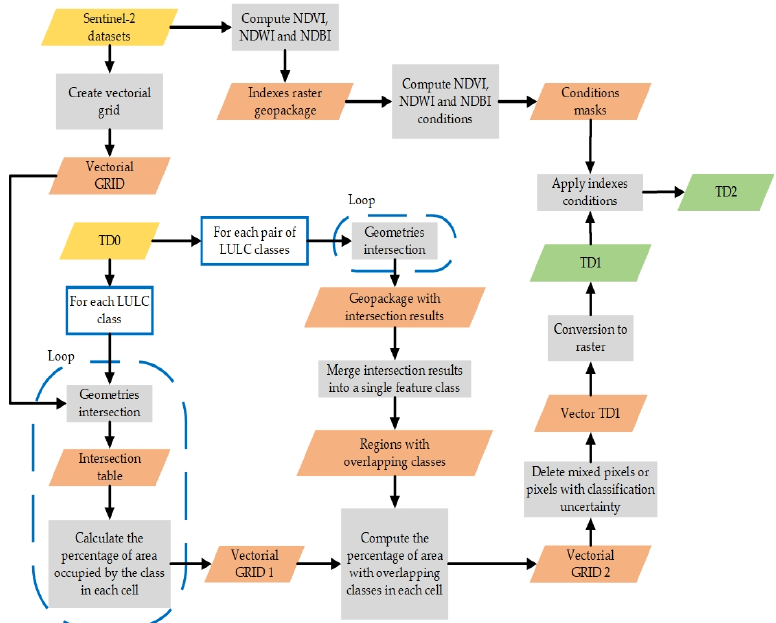
Figure 6. Workflow of the filtering process used to generate two additional training sets (TD1 and TD2) from TD0, obtained from the original OSM data after the application of the OSM2LULC_4T conversion